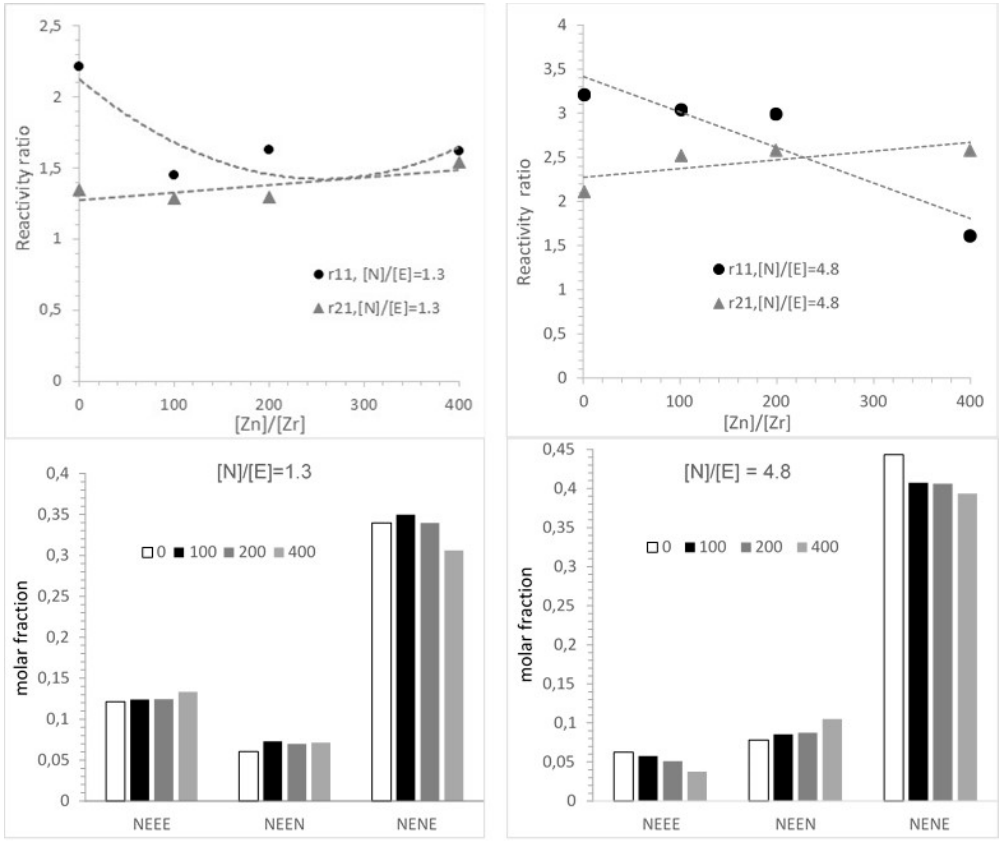
Figure 5. Comparison of microstructural analysis of poly(E- co -N)s obtained with catalyst 1 at 1.3 and 4.8 [N]/[E] feed ratios in the presence of increasing amount of ZnEt 2 : ( top ) r 11 and r 21 values (A); and ( bottom ) NEEE, NEEN and NENE tetrad molar fractions (B).